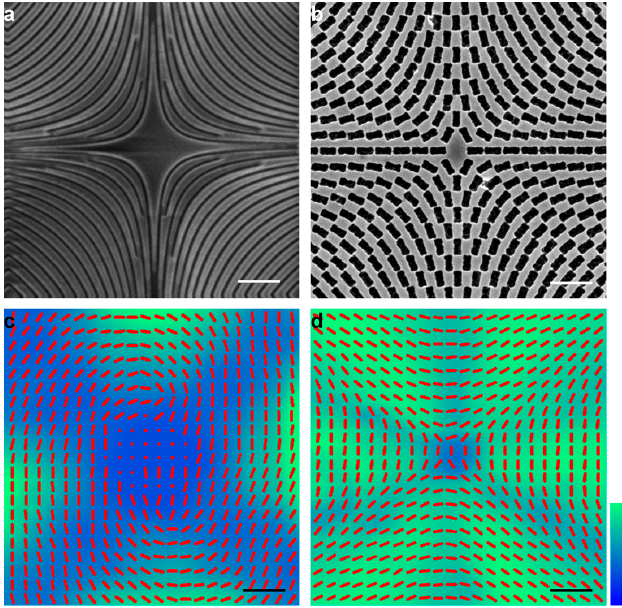
Figure 4. A comparison between the nanoslit-based and the nanoaperture-based PMMs. ( a ) SEM picture of a − 1 defect created with the nanoslits; ( b ) SEM picture of a − 1 defect generated by the nanoaperture arrays; ( c ) Measured polarization orientations and optical transmittance of the PMM in ( a ); ( d ) Measured polarization orientations and transmittance of the PMM in ( b ). The scale bars in ( a – d ) are 1 μ m, and the scale bar on the right-hand side indicates the optical transmittance in ( c , d ).